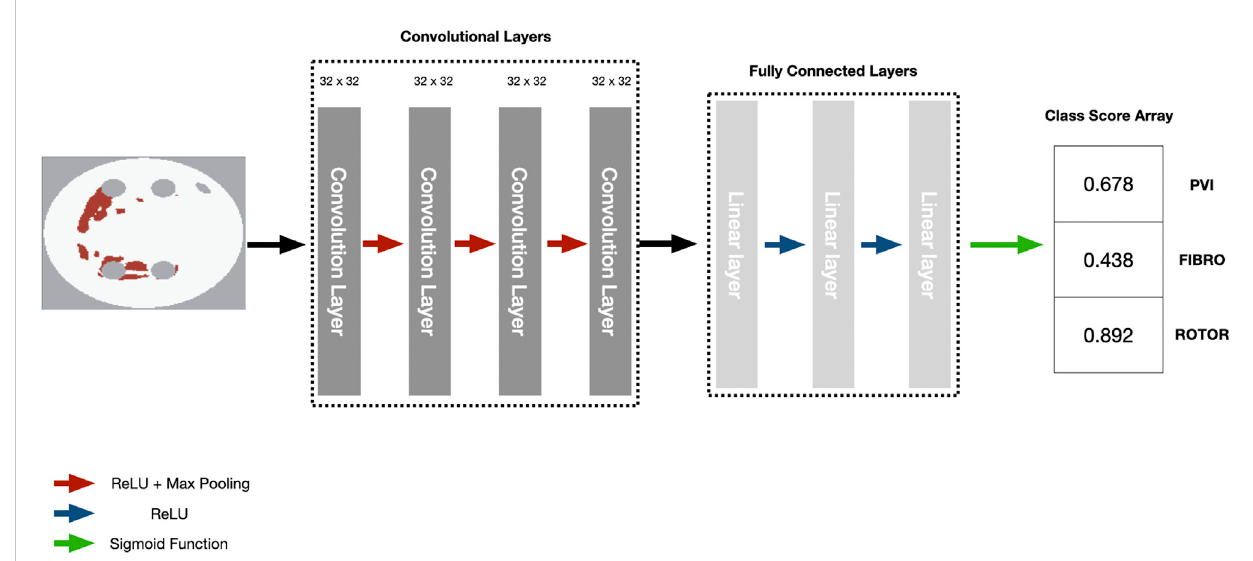
FIGURE 2 Diagram of CNN with parameters to predict RFCA simulation strategy success from 2D LA